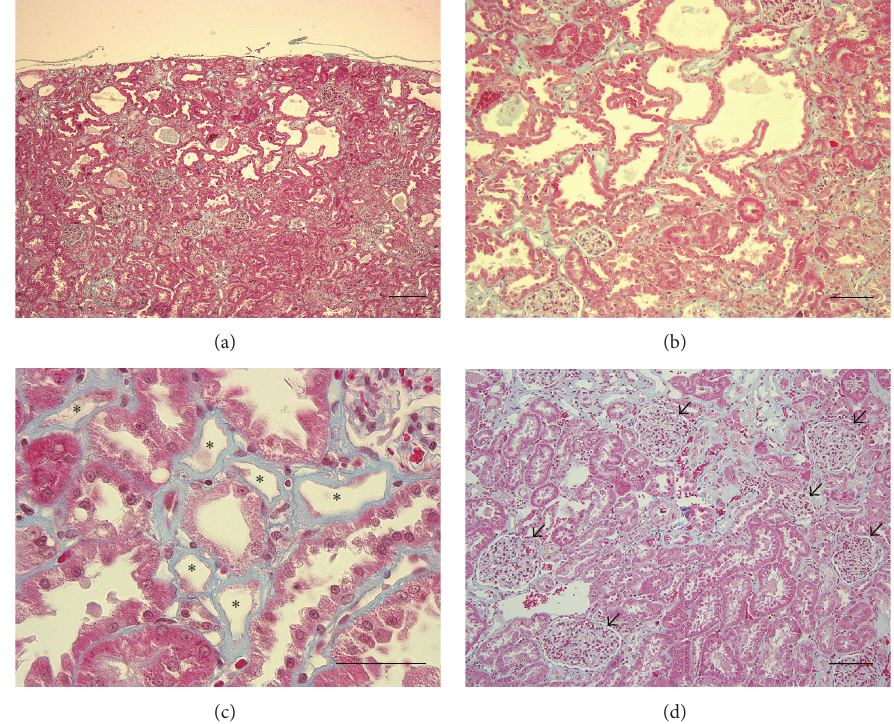
Figure 5: Histopathological appearance of renal tissues from male LEA rats at 12 months of age. Stained with Masson’s Trichrome (a–d). Epithelial layer effacement (asterisk), Glomeruli (arrow). Scale bars = 200 𝜇 m (a), 100 𝜇 m (b and d) and 50 𝜇 m